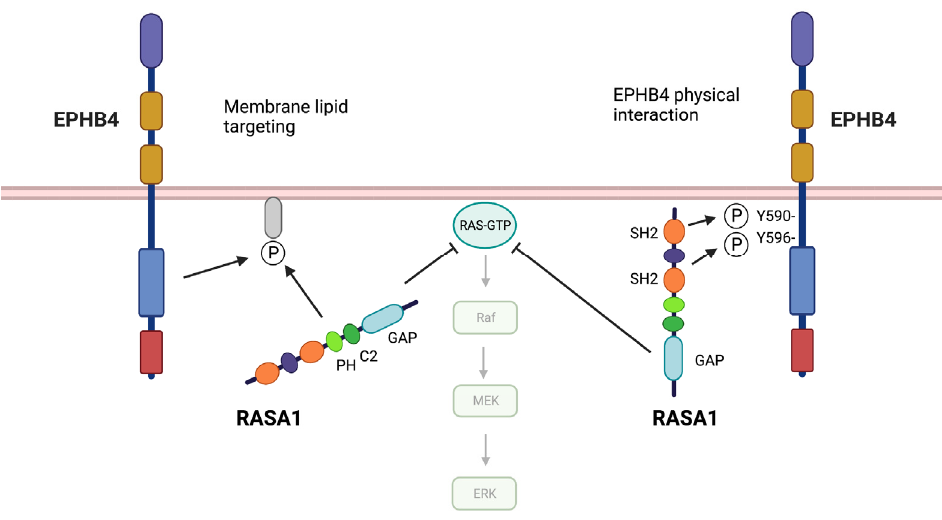
Figure 3. Models of EPHB4 and RASA1 cooperation in EC. Left, EPHB4 signaling generates mem- brane lipids that are ligands of the RASA1 PH domain leading to RASA1 membrane localization and juxtaposition to Ras-GTP. Right, RASA1 membrane localization is mediated through SH2 domain recognition of phosphorylated tyrosine residues in the EPHB4 JM region. Note that this latter mecha- nism of EPHB4–RASA1 interplay is not required for developmental angiogenesis or neoangiogenesis in mice.